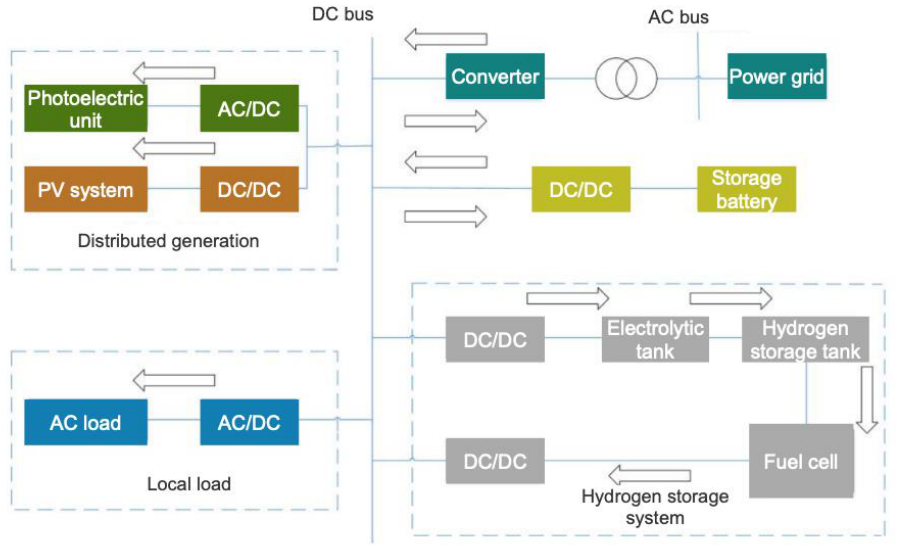
Figure 11. Hybrid energy storage microgrid structure with hydrogen storage.